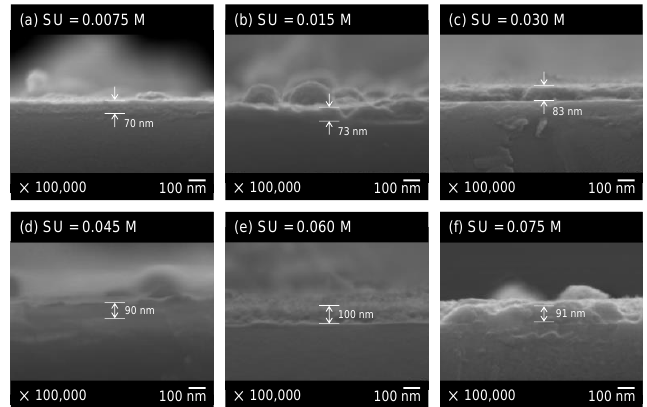
Figure 3. FESEM images of cross-sectional views for Zn(Se,OH) films deposited with a constant selenourea concentration of 0.03 M, and the NH 4 OH concentrations of ( a ) 0.6 M; ( b ) 1.2 M; ( c ) 1.4 M; ( d ) 1.8 M; ( e ) 2.2 M and ( f ) 2.6 M.